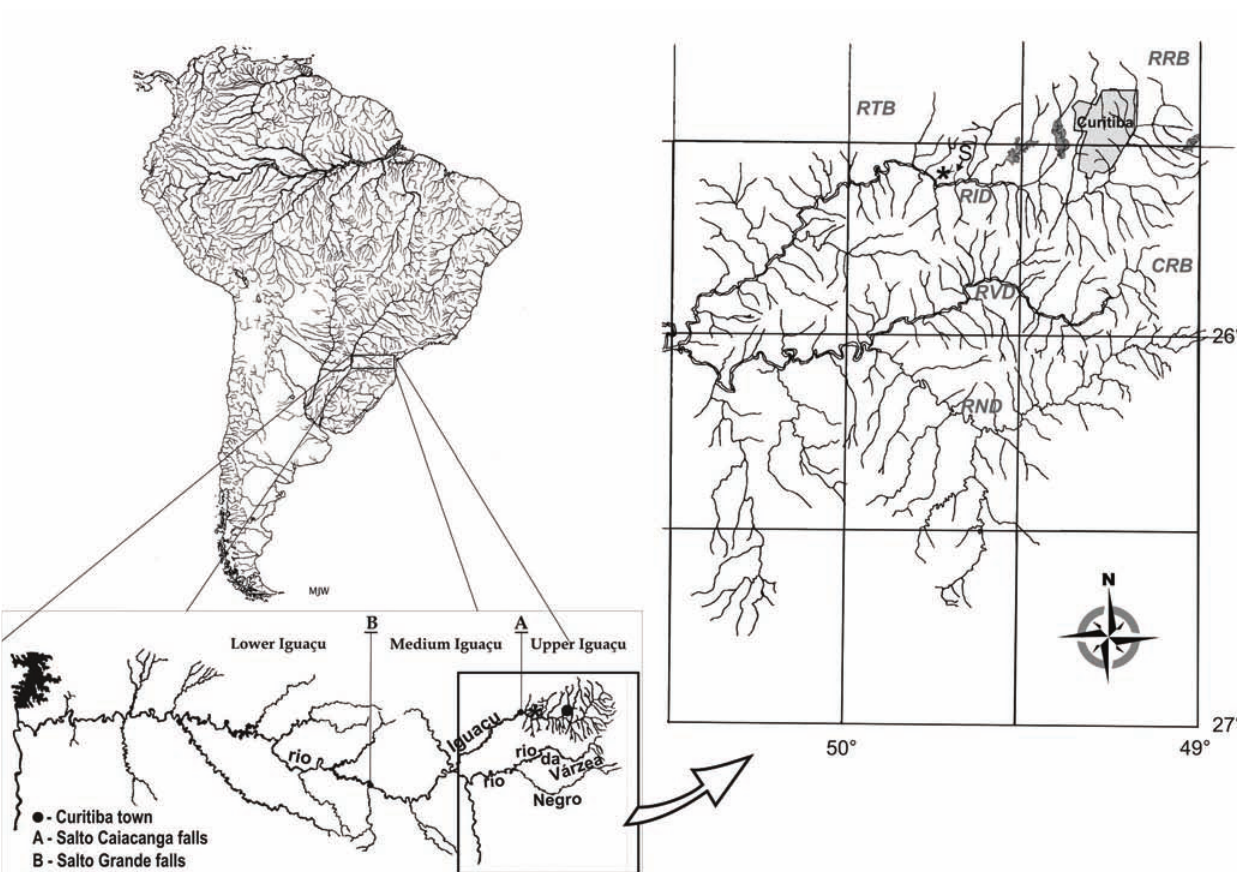
Fig. 5. Distribution of Astyanax eremus , new species, in rio Iguaçu basin (*). Vertical bars indicate biogeographic barriers of the rio Iguaçu according to Ingenito et al. (2004) (A and B). Serrinha from Haseman & Eigenmann (1911) (S). Coastal At - lantic rivers from Southeastern Brazil (CRB). Rio Iguaçu drainage (RID). Rio Negro drainage (RND). Rio Ribeira de Iguape drainage (RRB). Rio Tibagi drainage (RTB). Rio da Várzea drainage